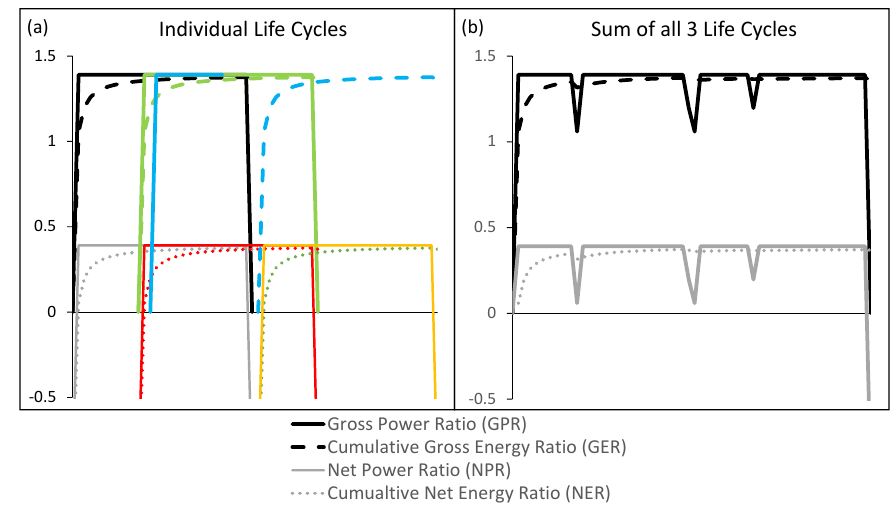
Figure 3. This figure shows that when multiple technologies are installed over time, the instantaneous power return ratios (PRRs) and the cumulative energy return ratios (ERRs) can end up greater than or less than each other (but GER > NER and GPR > NPR). ( a ) Individual gross power ratio (GPR), net power ratio (NPR), cumulative gross energy ratio (GER) and cumulative net energy ratio (NER) for each of the three technology installations based upon the time of installation; ( b ) The summed GPR, NPR, GER, and NER from all three technology installations.